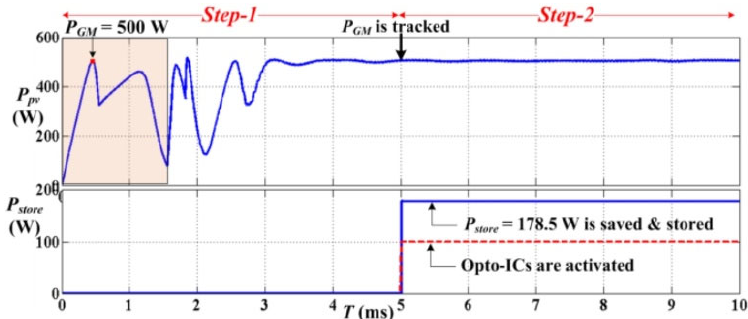
Figure 8. Case 1: operation of the suggested hardware system where additional 178.5 W energy is stored in the battery .